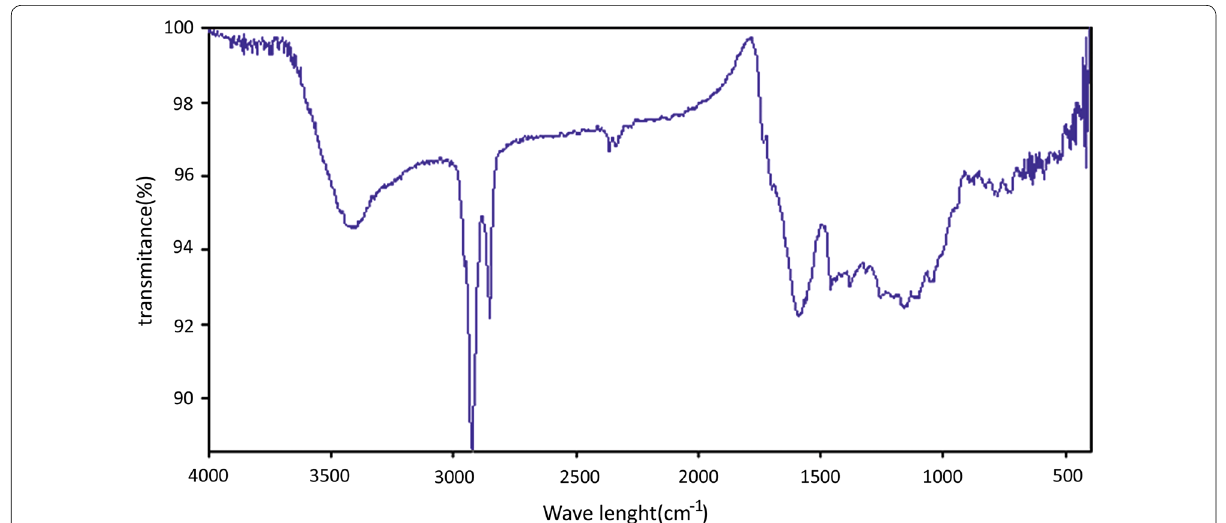
Fig. 2 FT-IR spectrum of Fe 2 + modified pomegranate peel carbon